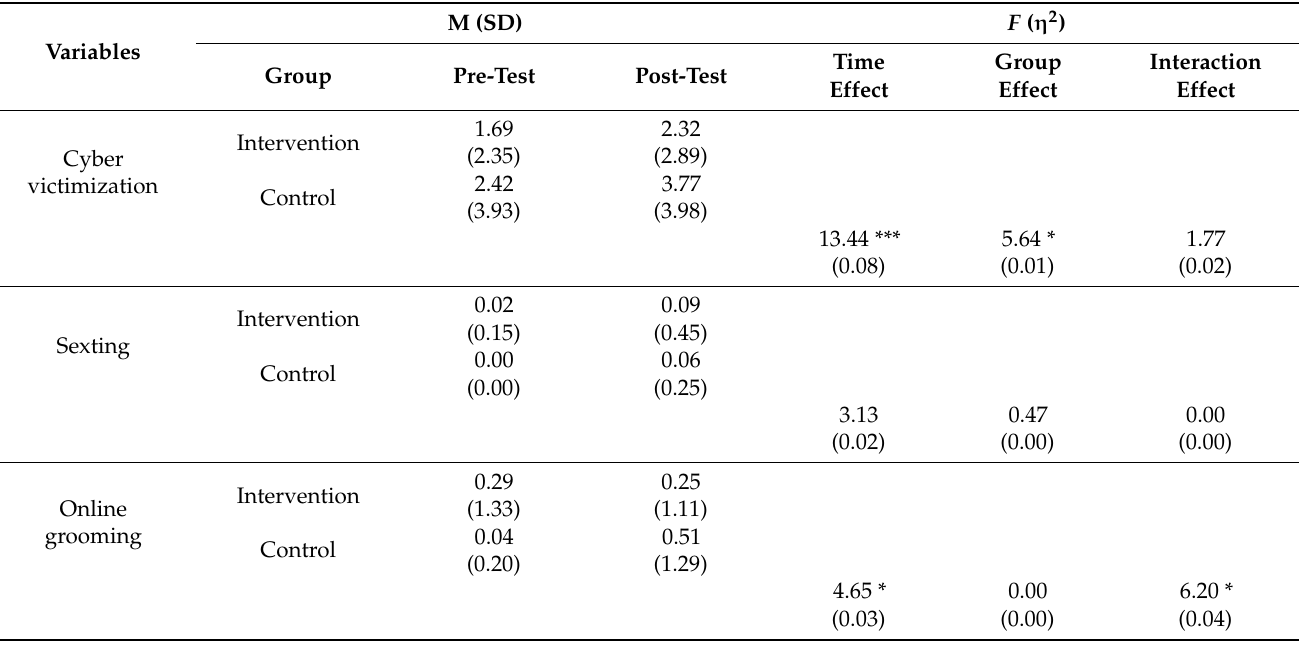
Table 3. Intergroup effects and repeated measures analysis of variance (ANOVA 2 × 2) in relational Internet risks. M (SD) Variables Group